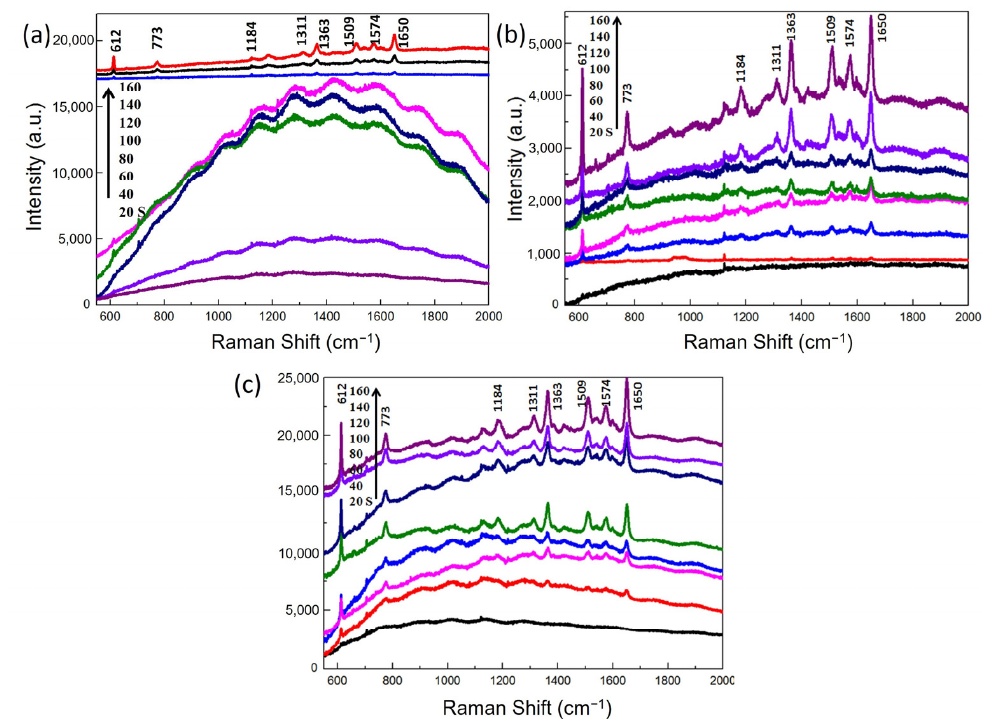
Figure 5. Raman spectra of R6G detected from three sets of SERS substrates, Au@Si ( a ), Au@ZnO-film ( b ) and Au@ZnO-NRs ( c ).